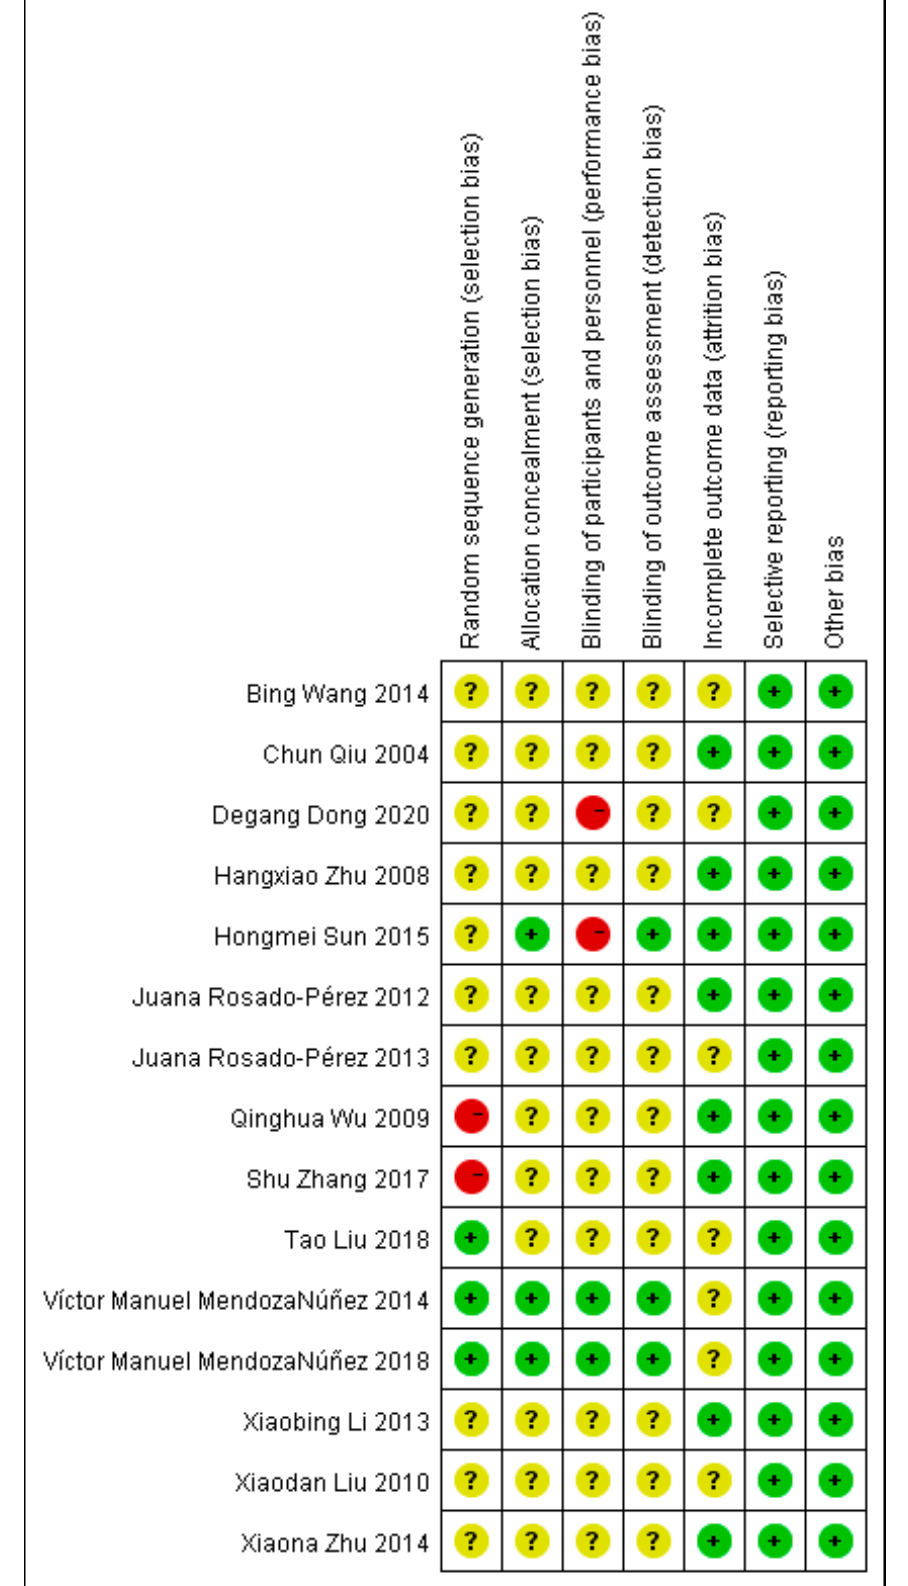
Figure 3. “Risk of bias” summary of included studies.